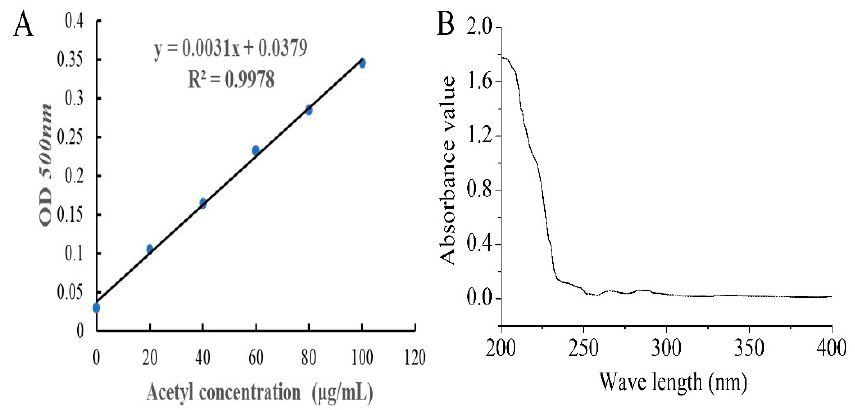
Figure 1. Preparation of acetylated Pleurotus geesteranus polysaccharides (AcPPS). ( A ) The standard curve of acetyl content. ( B ) Ultra-violet (UV) analysis.